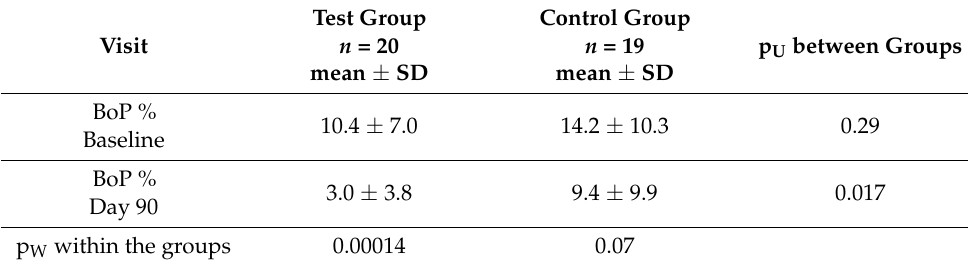
Table 2. Percentage of sites being positive for bleeding on probing